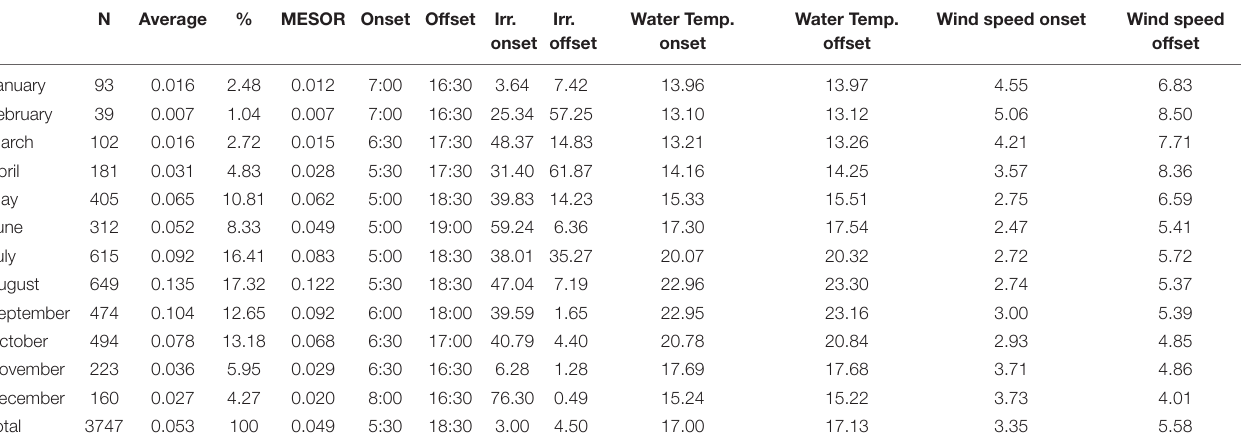
TABLE 1 | Monthly D. dentex visual counts number (N), average and relative percentage (%) out of the total within the 2012-2019 monitoring period. N Average % MESOR Onset Offset Irr.